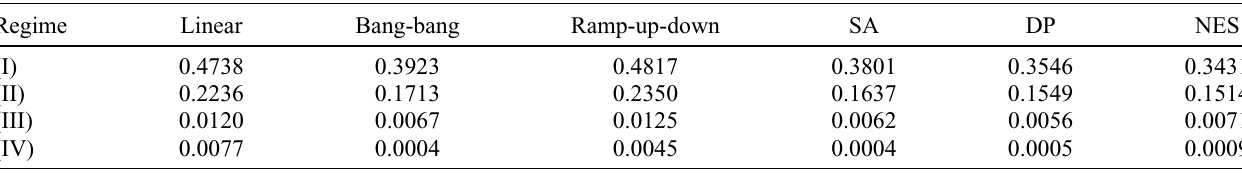
TABLE I. Results for the infidelity I ( T ) of different benchmark protocols (first three columns) in regimes (I)–(IV) compared to results obtained with SA, AD, and NES. For these simulations ( l , T ) are { ( 4.32, 12 ) , ( 4.95, 22 ) , ( 0.48, 8 ) , ( 2.4, 40 ) } , N = 110 and the other parameters of the Majorana wire setup are the same as for Fig. 2 in the main text. Regime Linear Bang-bang